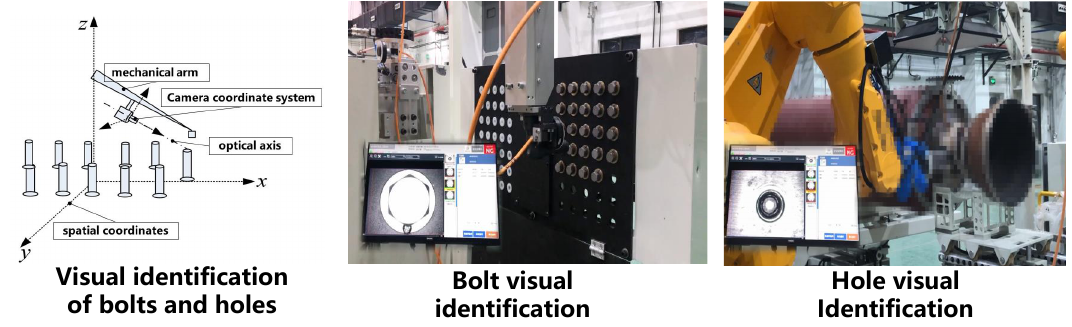
Figure 18. Real-time monitoring of aero-engine bolt tightening.